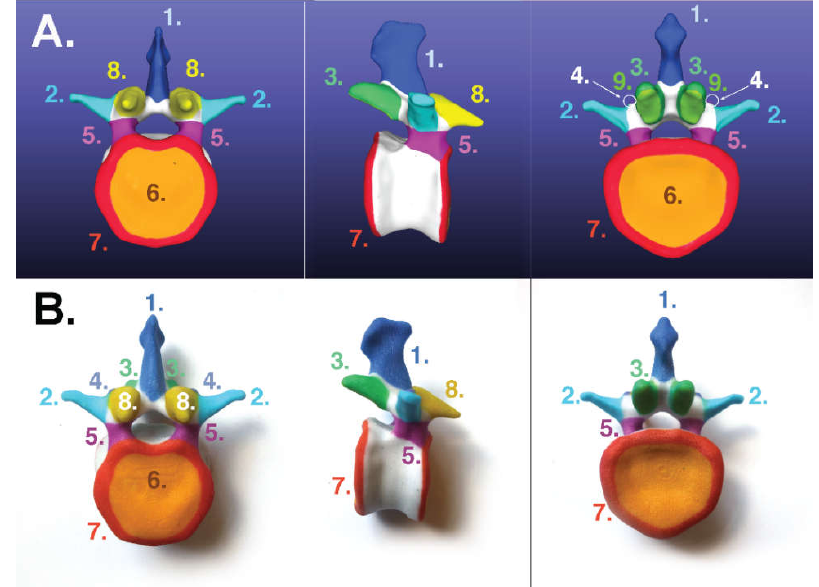
Figure 4. Panel A: Digital colored model (colored in Meshmixer, shown in Meshlab). Panel B: Resulting binder-jet printed lumbar vertebra including 1. spinous process, 2. transverse process, 3. inferior articular facet, 4. accessory process, 5. pedicle, 6. facies intervertebralis, 7. ring apophysis, and 8. superior articular facet.